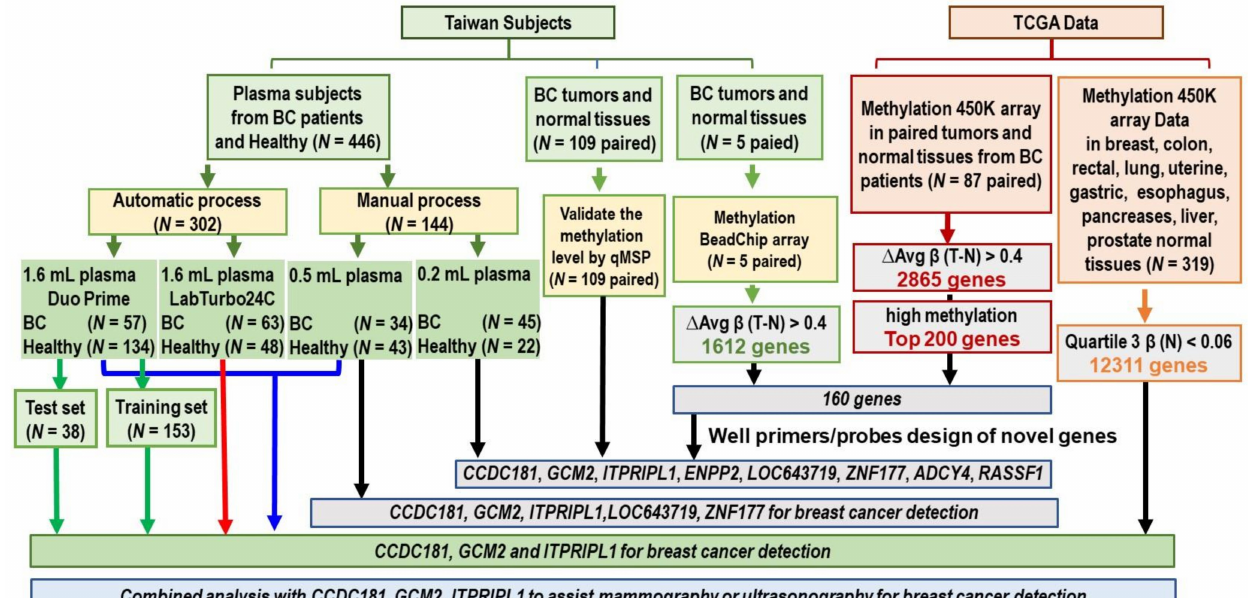
Figure 1. Flowchart of the gene selection, study design, datasets and specimens used (i.e., the criteria and steps used for gene selection). For each step, the sample types and number of samples used for the analyses are indicated. ∆ Avg β , β value in the tumor − β value in normal tissue; β , the DNA methylation level ranged from 0 (unmethylated) to 1 (completely methylated); BC, breast cancer; EPIC, Infinium MethylationEPIC array; methylation450K array, Infinium HumanMethylation450 BeadChip array; qMSP, quantitative methylation-specific